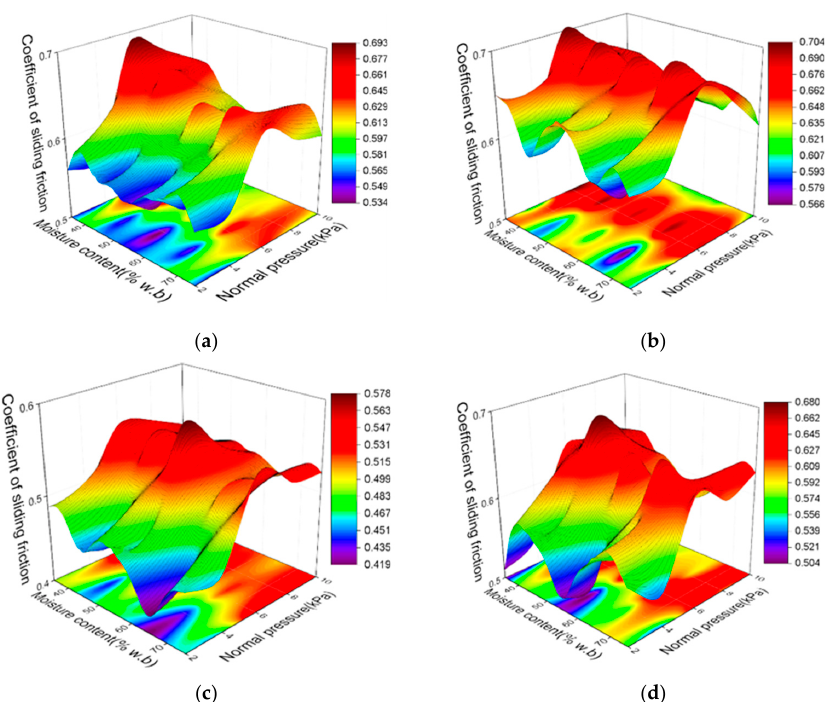
Figure 5. Effects of the moisture content and normal pressure on the coefficient of sliding friction of untreated straw (( a ): untreated wheat straw on mild steel; ( b ): untreated wheat straw on alumi- num; ( c ): untreated rice straw on mild steel; ( d ): untreated rice straw on aluminum).